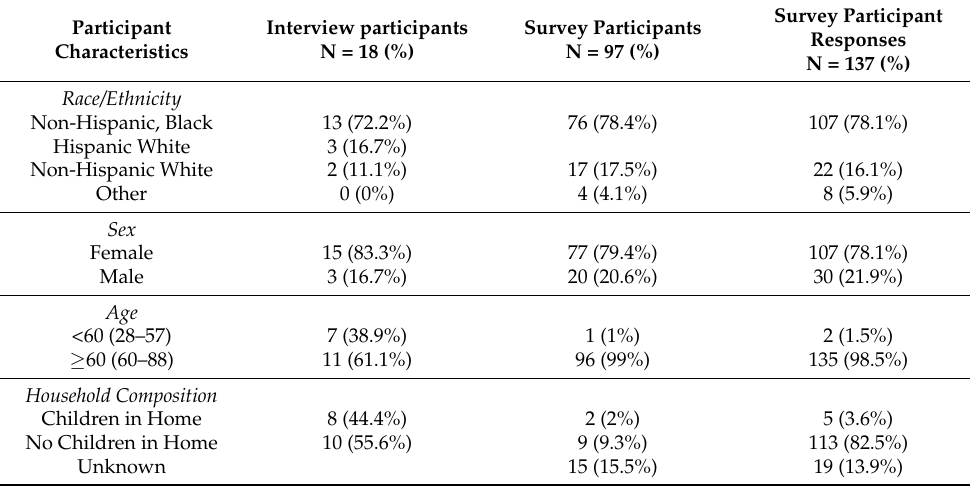
Table 4. Characteristics of Interview and Survey